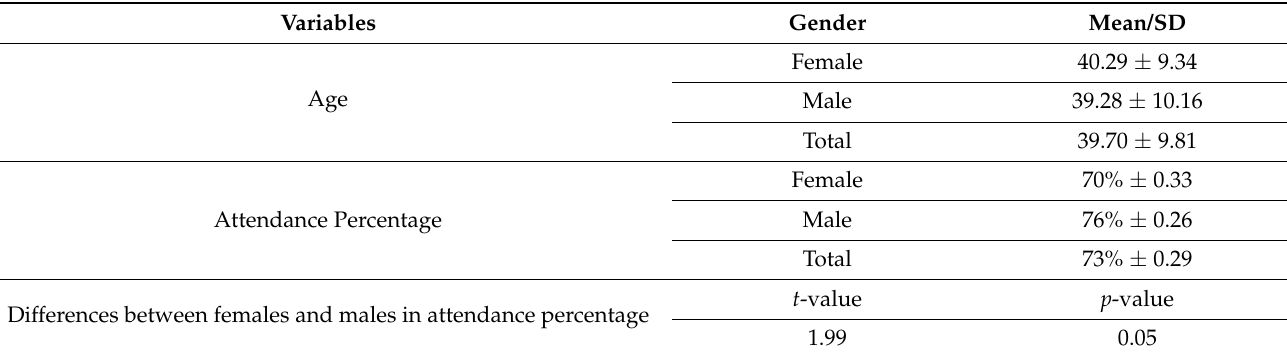
Table 1. Descriptive characteristics of the study sample.